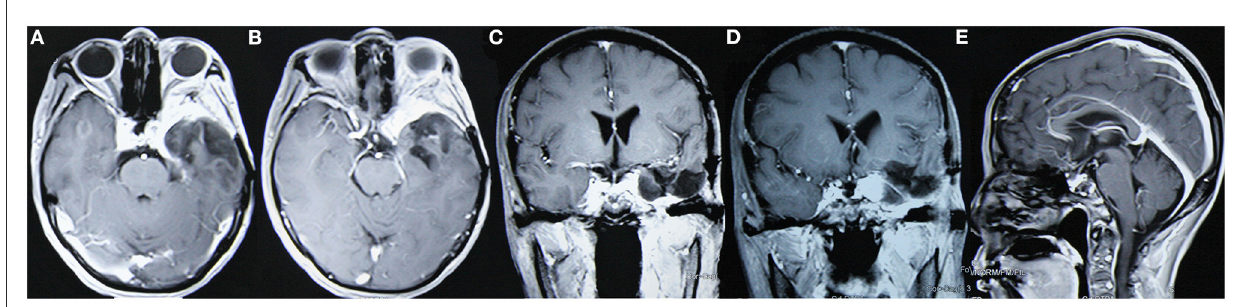
FIGURE4 The tumor did not relapse as suggested in enhanced MRI reexamination 3 years after surgery. (A, B) Enhanced axial images show no tumor relapse in the central skull base; (C, D) enhanced coronal images show no tumor relapse in the cavernous sinus. (E) The enhanced sagittal image shows no tumor relapse in the anterior skull base.